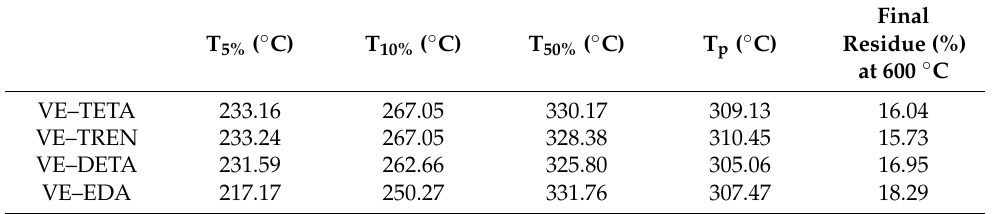
Figure 7. TGA curves of vanillyl alcohol–based bioepoxy resin cured by various curing agents. Table 3. Thermal properties of vanillyl alcohol–based bioepoxy resin cured by various curing